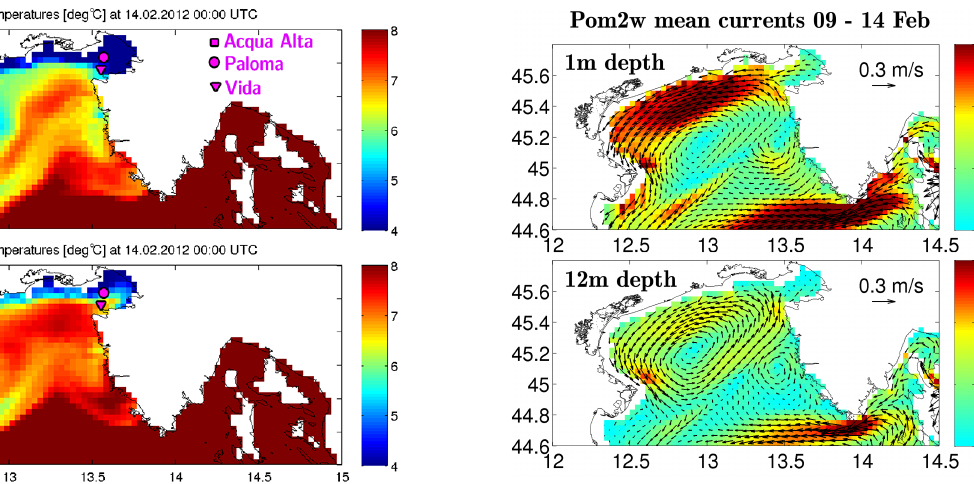
Figure 13. Sea surface temperature [ ◦ C] in POM1w (top panel) and POM2w (bottom panel) at the end of the bora event on 14 February 2012, 00:00UTC. Stations locations are drawn in pink color as a square (Acqua Alta), circle (Paloma) and triangle (Vida).